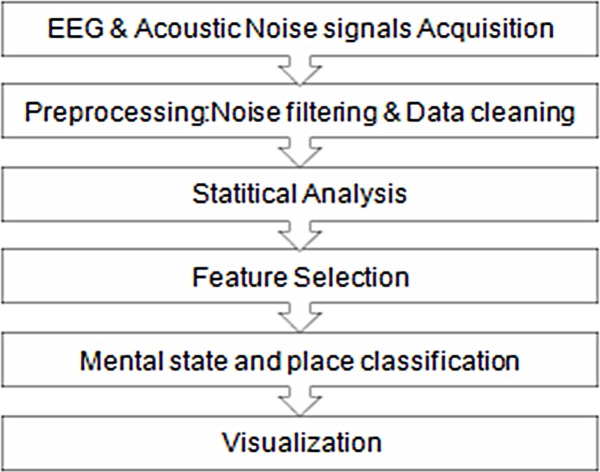
System architecture.